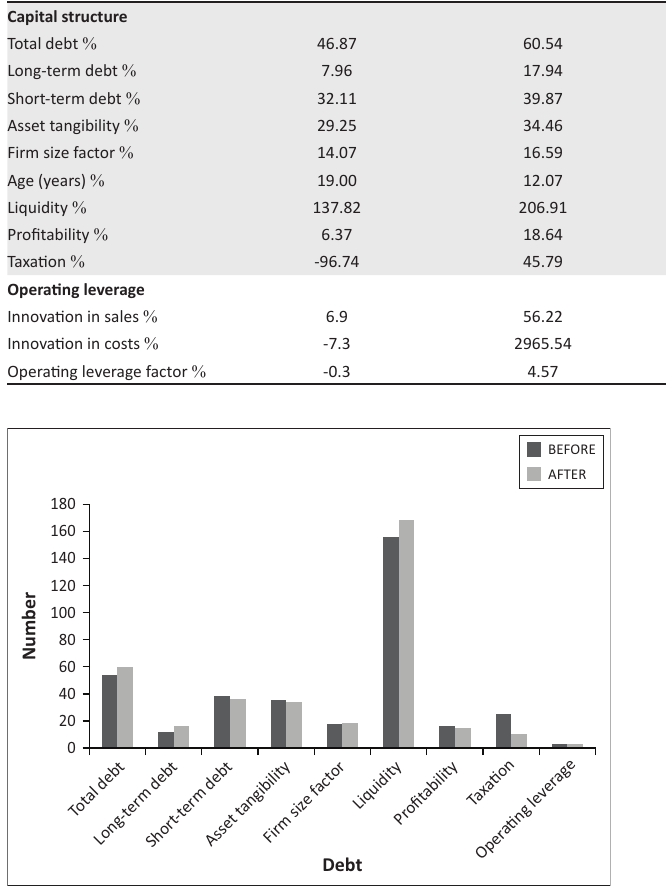
FIGURE 1: Total sample level: Mean comparison (before and after 2008).